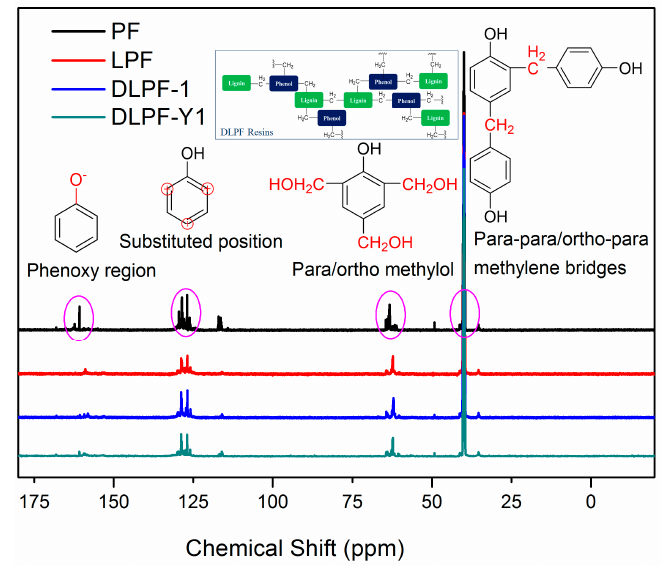
Figure 5. Liquid-state 13 C NMR spectra of PF, LPF, and DLPF resins.